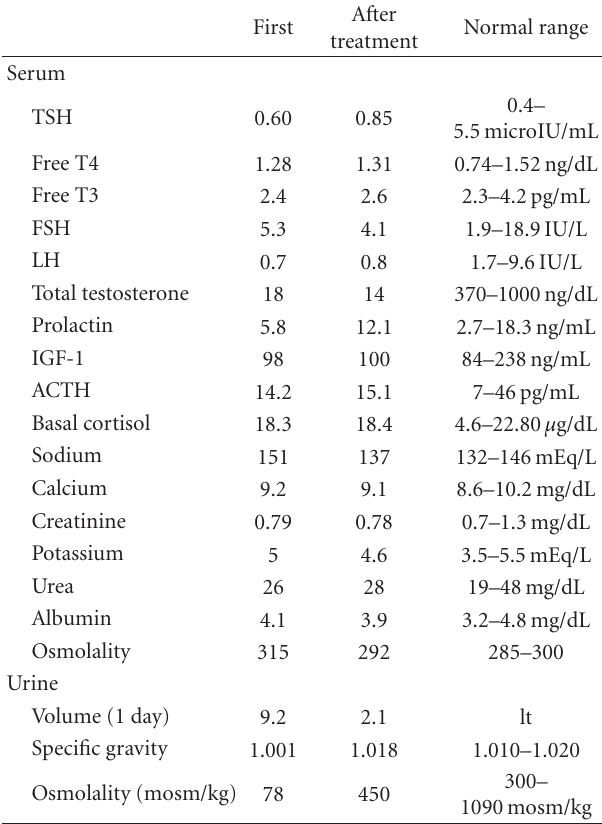
Table 1: Baseline and after treatment endocrinological and bio- chemical